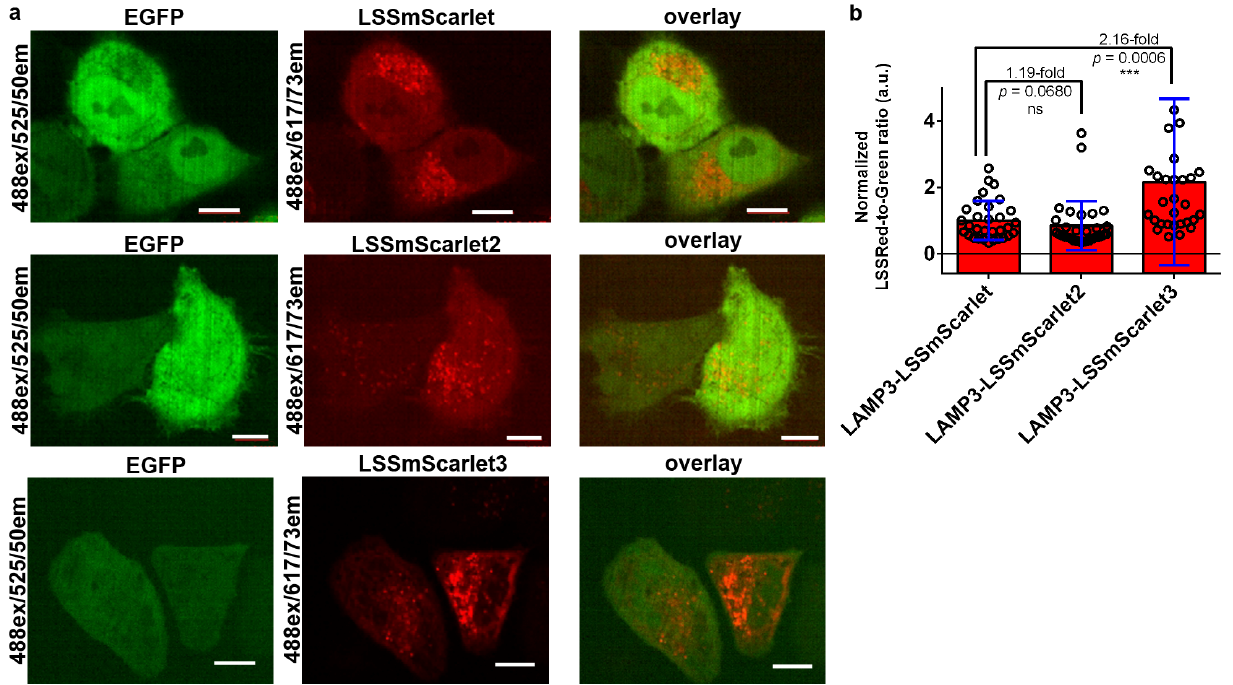
Figure 8. Comparison of the brightness of the LSSRFPs in fusions with LAMP3 inside the lysoso- mal lumen in HeLa cells. ( a ) Confocal images of HeLa cells coexpressing EGFP with the LAMP3-LSSmScarlet, LAMP3-LSSmScarlet2, or LAMP3-LSSmScarlet3 LSSRFP. LSSRed (488 ex and 617/73 em, in red color) and green (488 ex and 525/50 em, in green color) fluorescence chan- nels and their overlay are shown. Scale bar, 50 µm. ( b ) Averaged brightness for the LSSRFPs in lysosomes of HeLa cells normalized to the brightness of the EGFP expressed in the same cells. The error bars are the standard deviations across 29–32 cells. The p values show significant differences between the respective values. ns, not significant, p value > 0.05. ***, p value < 0.001.